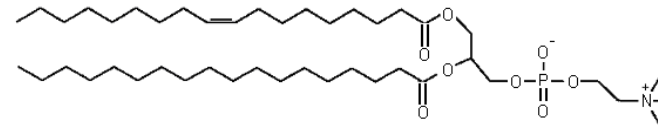
Figure 1. Phosphatidylcholine